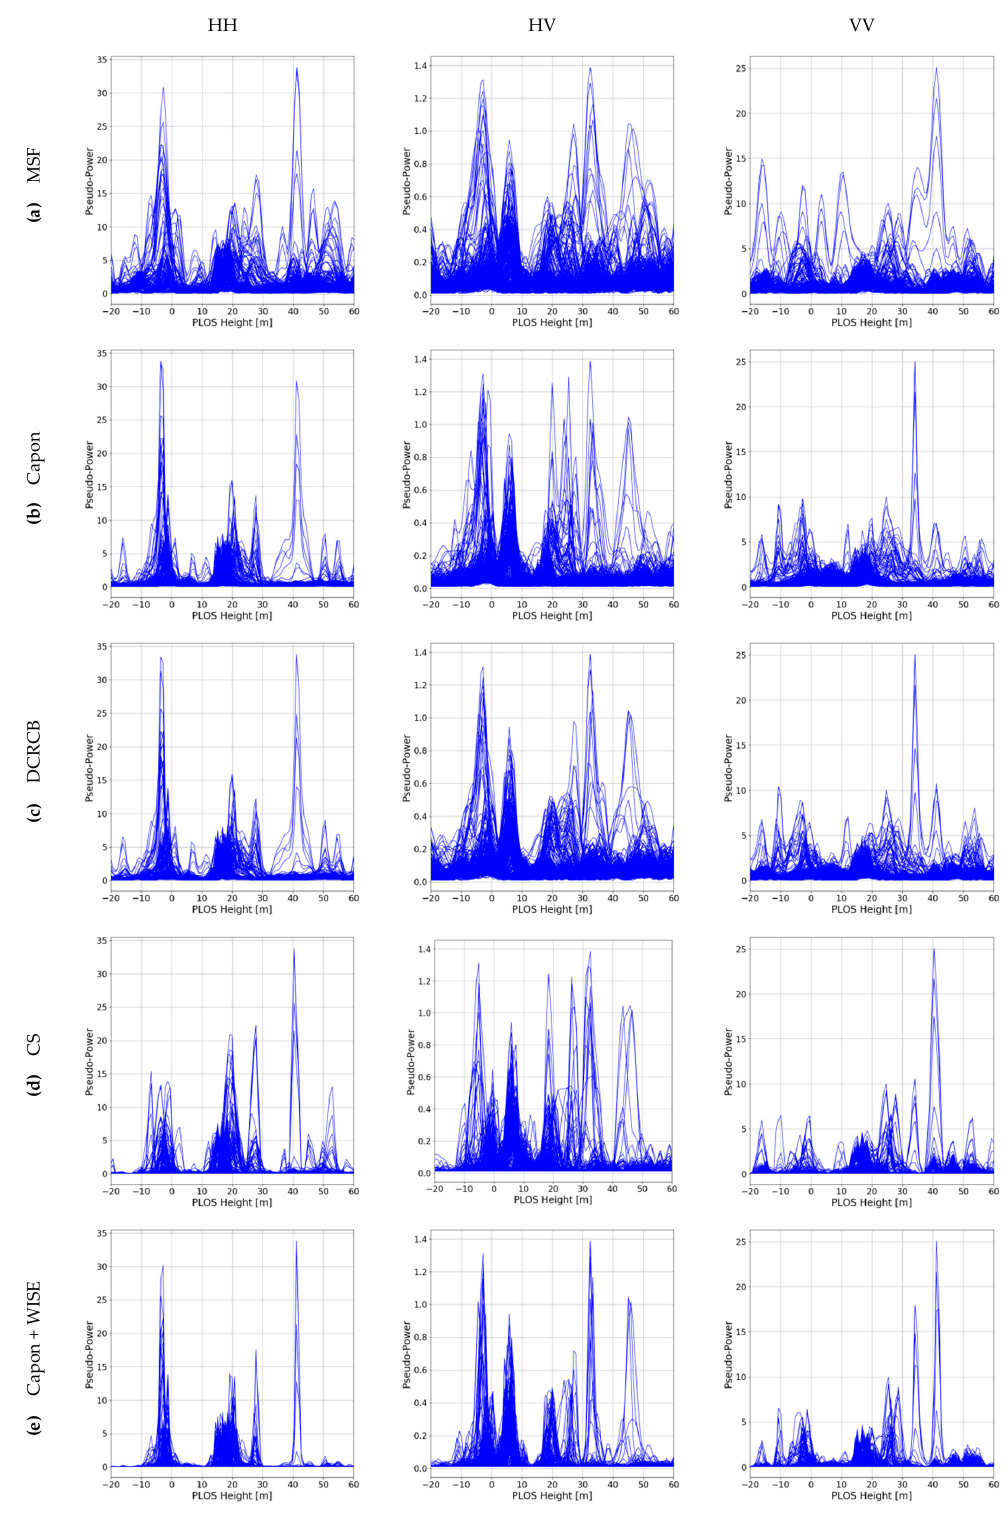
Figure 10. Two hundred and forty two superimposed vertical profiles spanning about 194 m along azimuth with a 1.2 ◦ slope, taken from the tomograms displayed in Figures 7–9: ( a ) MSF, ( b ) Capon, ( c ) DCRCB, ( d ) CS and ( e ) Capon + WISE. From left to right: HH, HV and VV. The (pseudo) power is presented in a linear